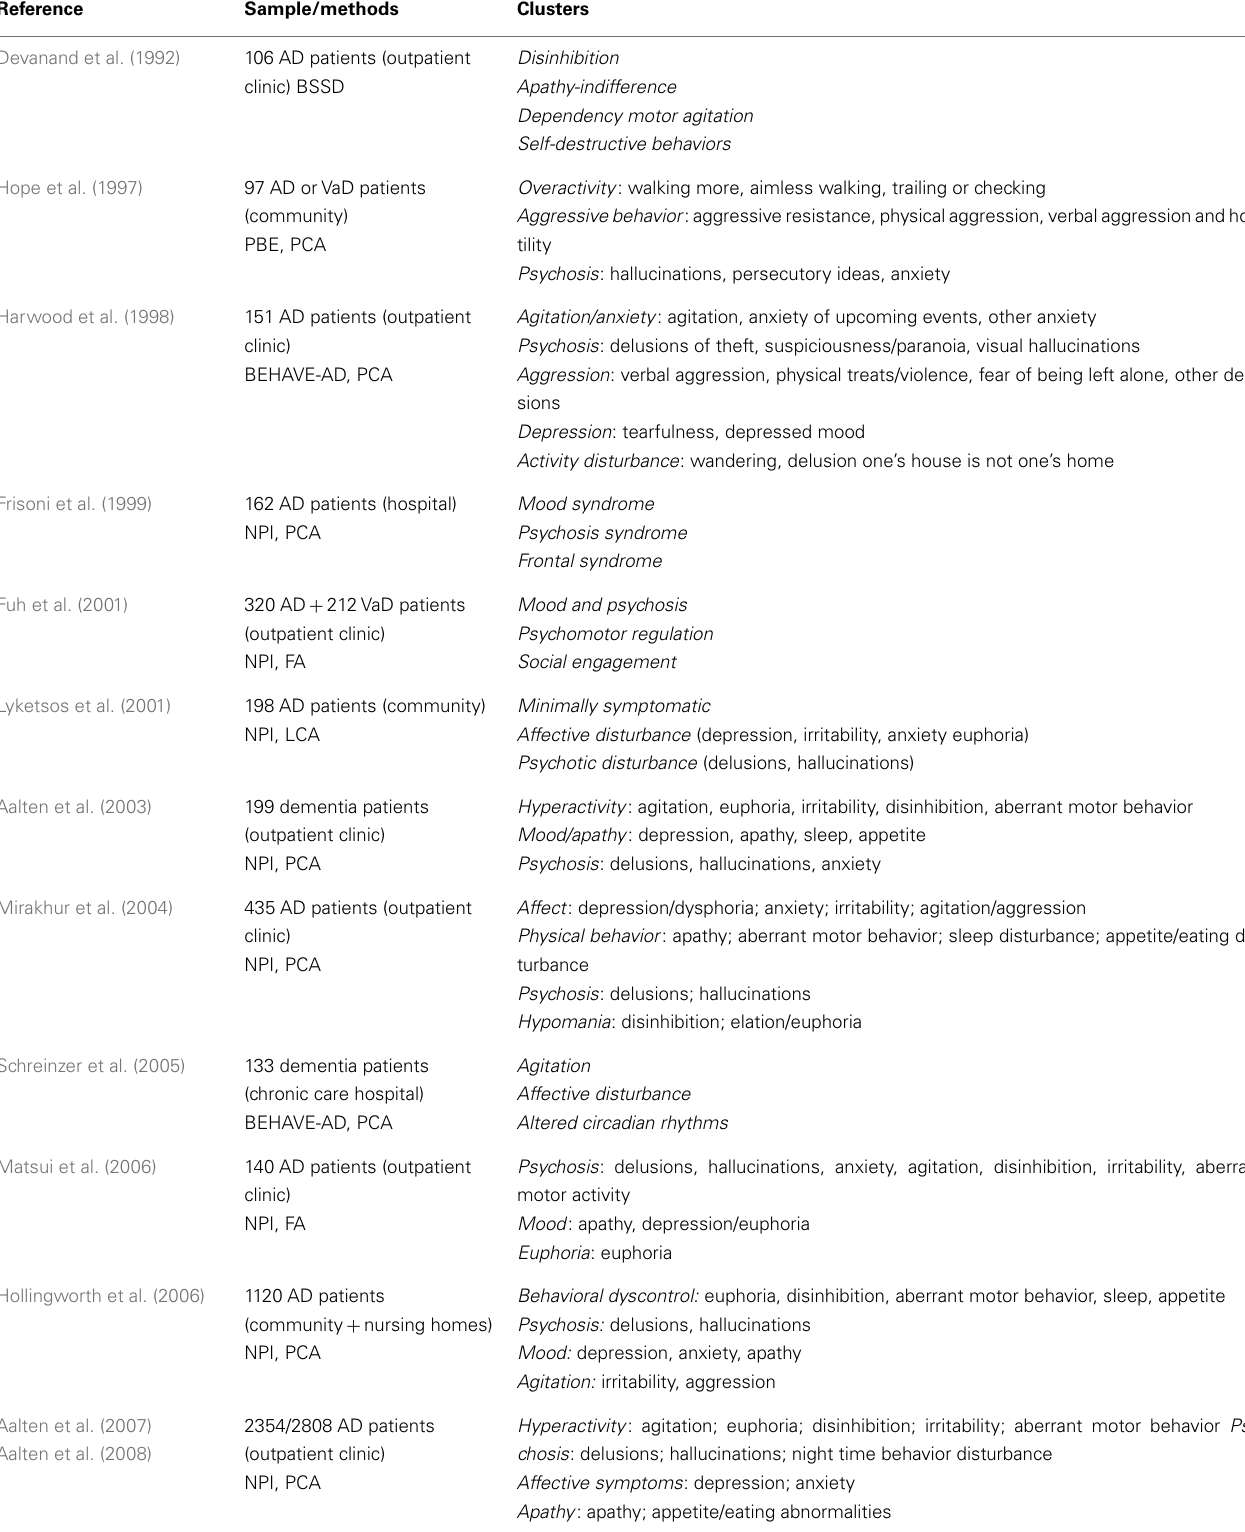
Table 1 | Neuropsychiatric sub-syndromes reported in patients with